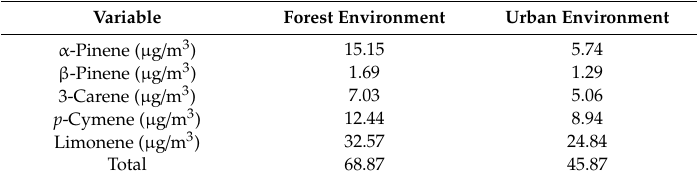
Table 3. Air phytoncides in the forest and urban